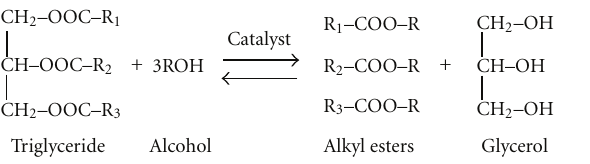
Figure 1: The general stoichiometric transesterification reaction diagram. Source: